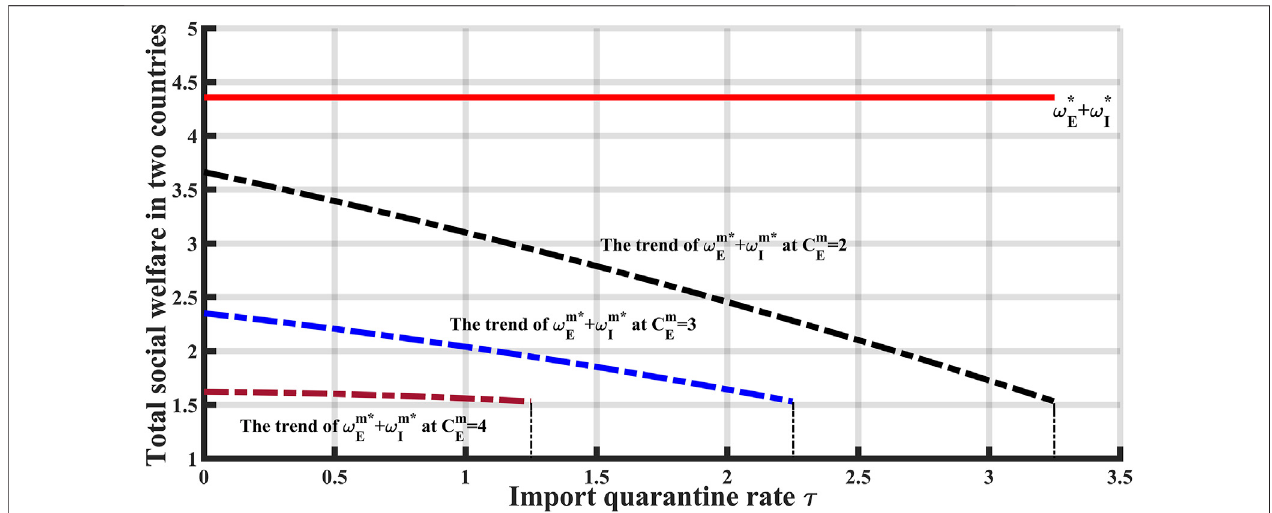
FIGURE 3 | Trend of total social welfare in two countries. (Source: Simulation data for numerical